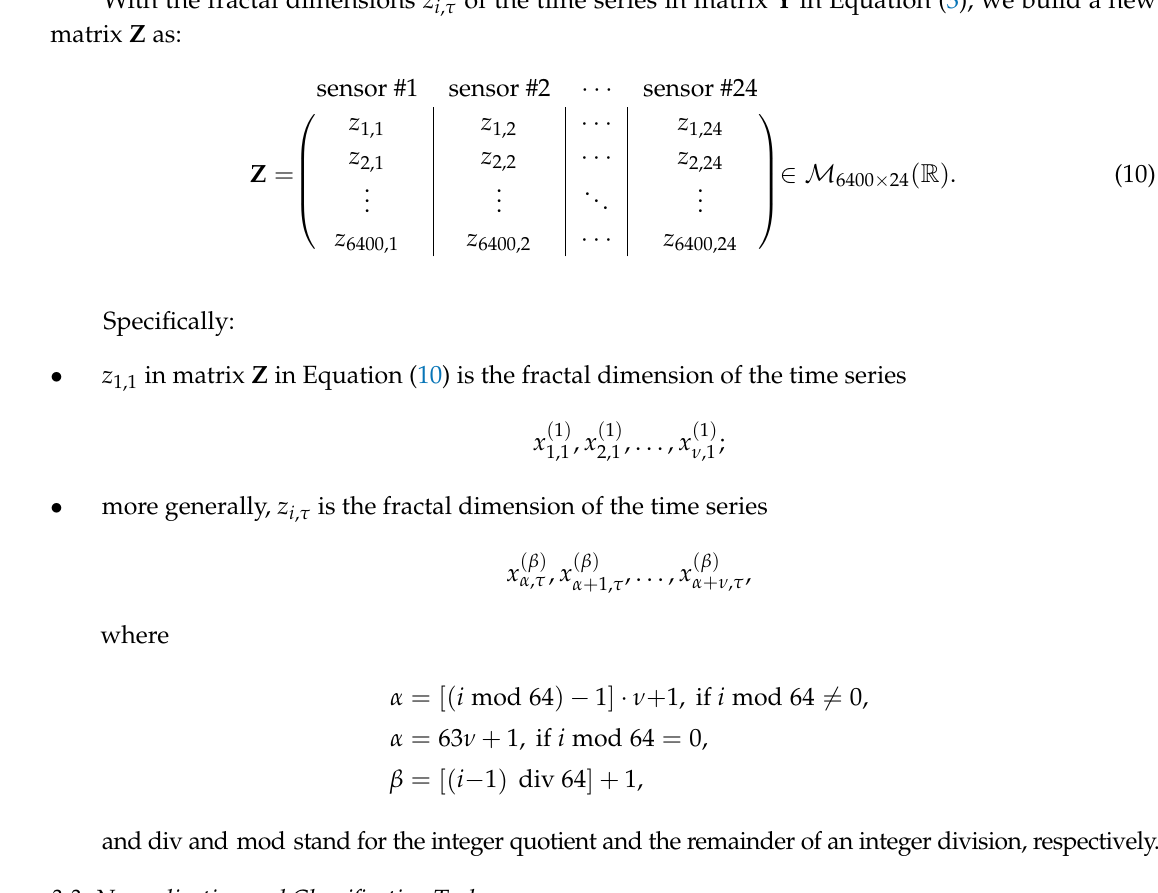
Figure 4: Original EPS image Figure 3. The diameter of a time series d is given by the distance between the first point and the point that provides the maximum